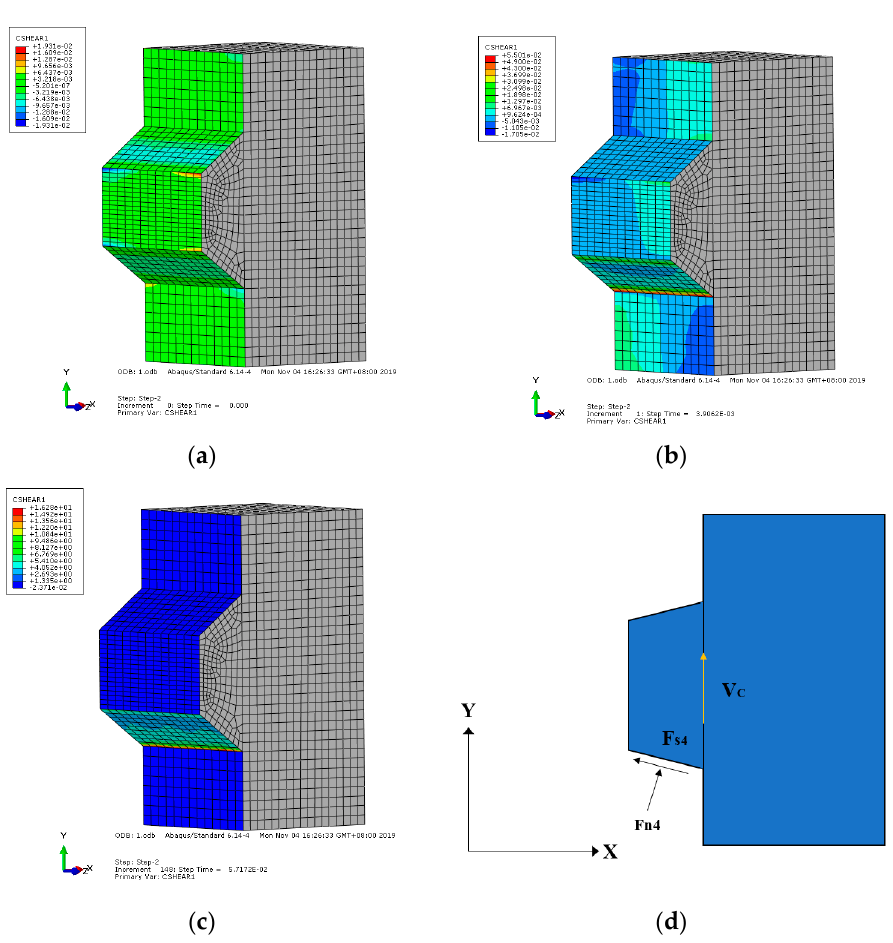
Figure 9. Vertical force component of tangential force at the contact surface; ( a ) under lateral prestress; ( b ) 0.004 V u state; ( c ) under ultimate load V u ; ( d ) diagram of forces on the